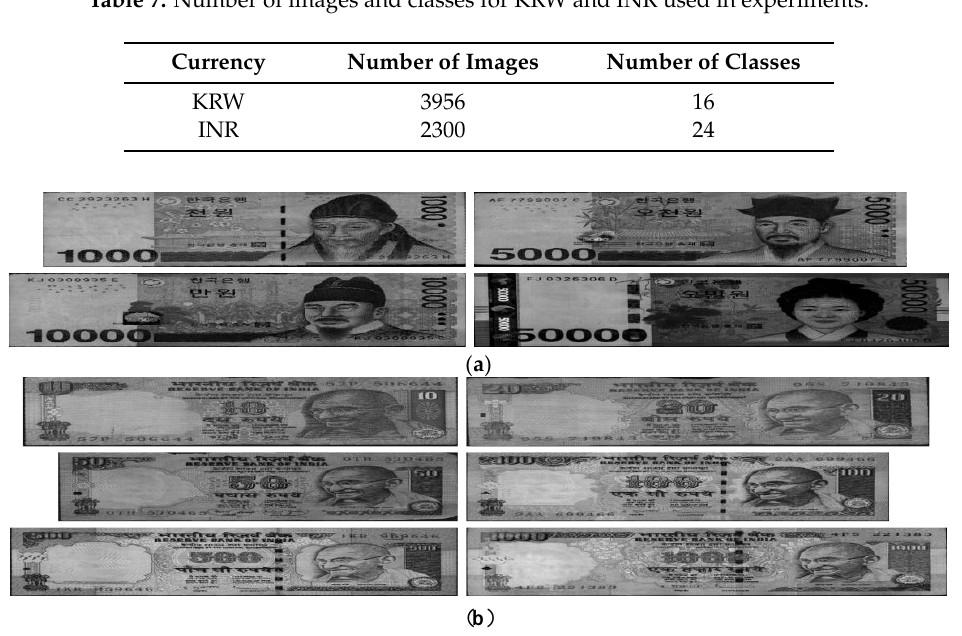
Table 7. Number of images and classes for KRW and INR used in experiments.